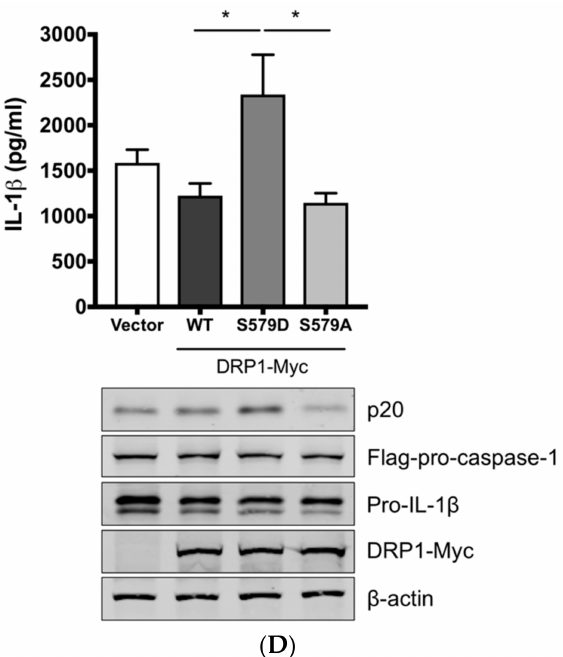
Figure 3. DRP1 is involved in the SIV-induced IL-1 β production in PAMs. PAMs were either infected with Sk02 at an MOI of 1 for 20 h ( A ) or stimulated with 200 ng/mL LPS for 16 h ( B ) in the presence of vehicle (DMSO) or increasing concentrations (5 and 20 µ M) of DRP1 inhibitor, Mdivi-1. Porcine IL-1 β levels from supernatants were measured by ELISA and the expression of pro-IL-1 β , viral NS1, and β -actin was analyzed by Western blotting. ( C ) Schematic representation of human DRP1 along with porcine DRP1. S579 in porcine DRP1 WT corresponds to S616 in human DRP1. D579 and A579 harbored by phospho-mimetic and phospho-deficient porcine DRP1 constructs, respectively, are displayed. ( D ) For NLRP3 inflammasome reconstitution assay, HEK293T cells were co-transfected with plasmids expressing porcine NLRP3 inflammasome components (NLRP3, ASC, and procaspase-1) and pro-IL-1 β along with Myc-vector or Myc-tagged WT/mutant porcine DRP1 for 16 h. Porcine IL-1 β levels from supernatants were measured by ELISA. The expression of caspase-1 (active and precursor forms) and pro-IL-1 β was analyzed by Western blotting. Statistical analysis was done with one-way ANOVA. * p < 0.05; *** p < 0.001. Results are representative of three independent